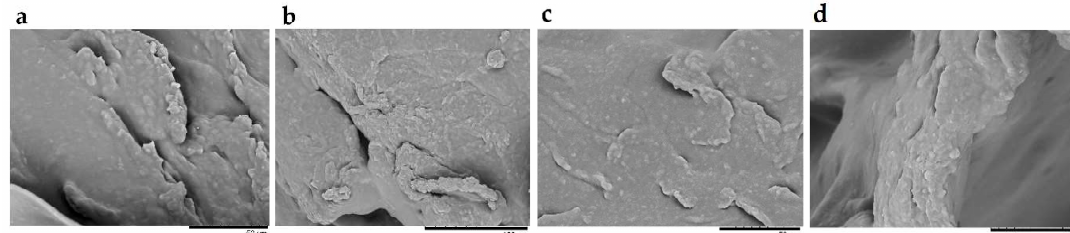
Figure 6. Scanning electron microscopy images of hydrogels F5 ( a ), F6 ( b ), F7 ( c ), and F8 ( d ); a, c, d—magnification × 1500, b—magnification × 1000.